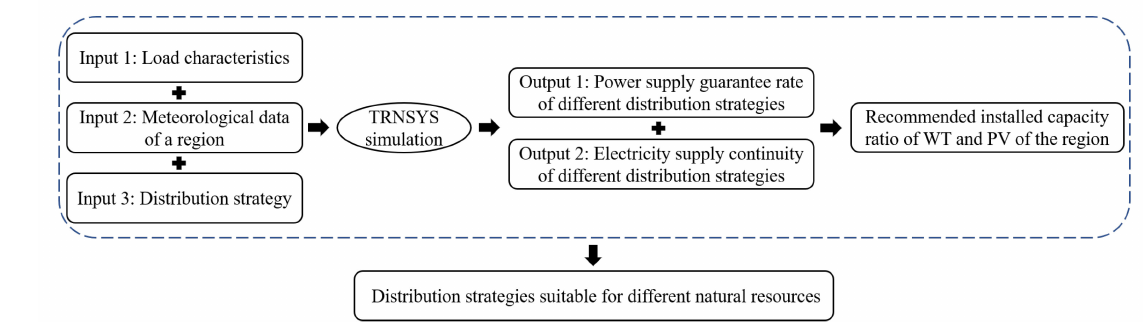
Figure 5. Flowchart for the methodology of this study.